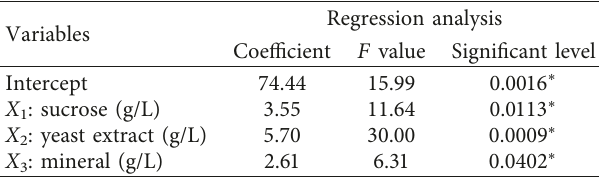
Table 2: FFD regression results for antifungal